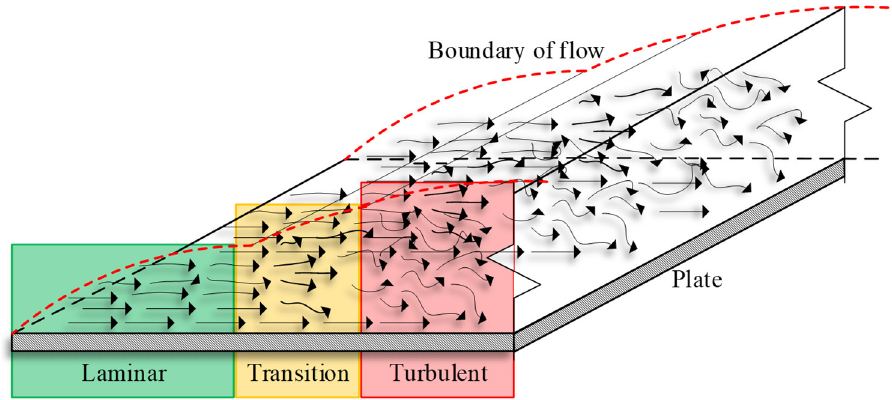
Figure 5. Heat flow modeling [11].